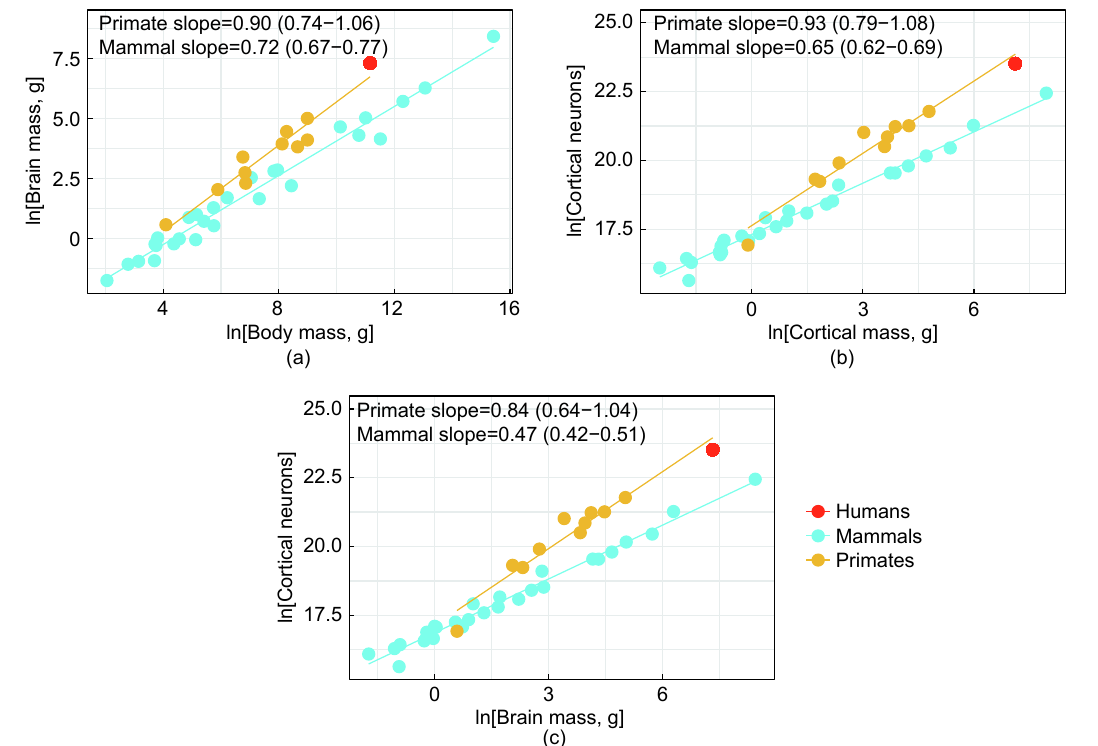
Fig. 1 Allometric scaling of brain mass, cortical mass, and cortical neurons across non-primate mammals (blue points), non- human primates (orange points), and humans (red point) using data from Herculano-Houzel et al. [61] (a) Brain mass increases with body mass slightly faster in primates than other mammals, though the difference in slopes is non-significant (see main text for statistical results). The human brain is large for an equivalently-sized mammal, but only slightly larger than expected for an equivalently-sized primate. (b) The number of cortical neurons increases with cortical mass faster in primates than in other mammals, and so primate brains have a much higher density of neurons in their cortices than other mammals. (c) The number of cortical neurons increases with brain mass nearly twice as fast in primates than in other mammals. Human brains have a near predictable number of cortical neurons for a primate, but more importantly they have more cortical neurons than any other mammal in the